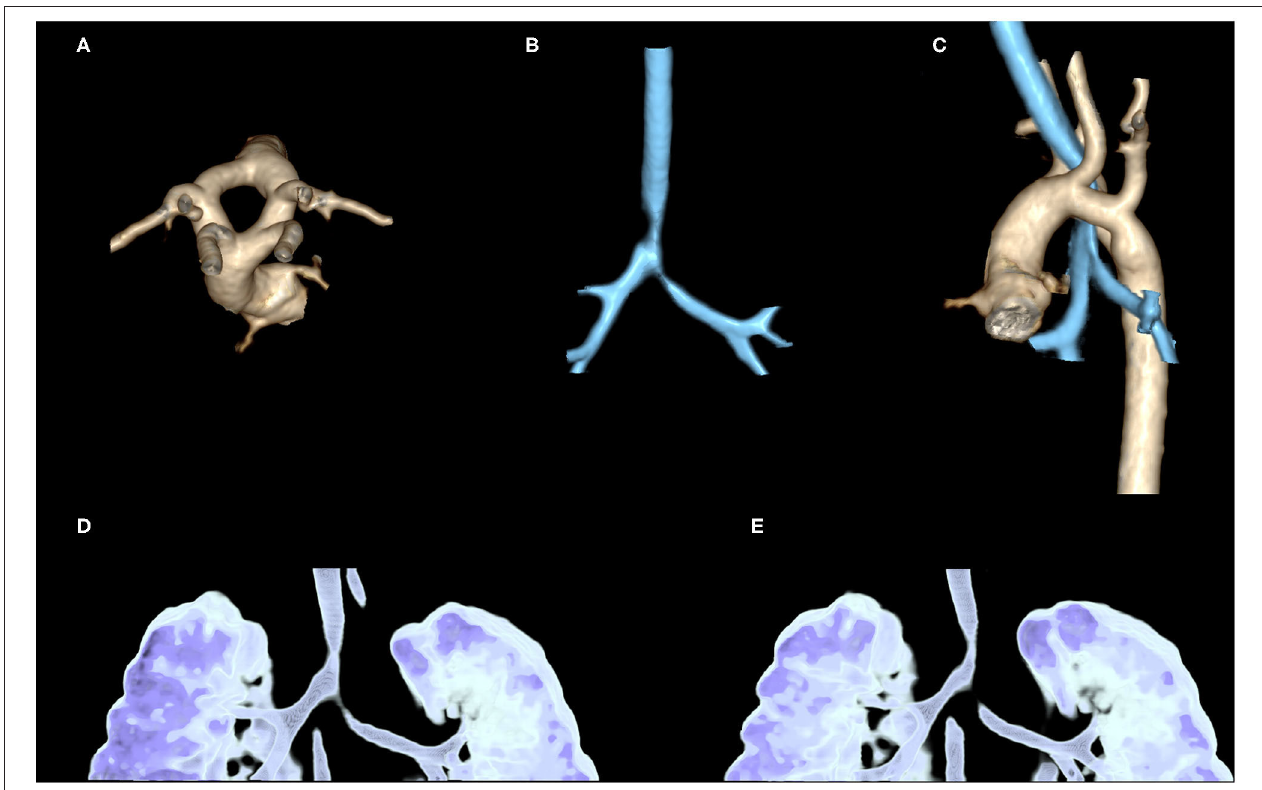
FIGURE 4 | Contrast-enhanced CT in a 2-month-old girl, referred to our hospital after prenatal diagnosis of vascular ring: three-dimensional (3D) volume rendering of thoracic aorta confirms the presence of a double aortic arc with two arches (left and right) equally sized (A) . 3D volume rendering of airways shows stenosis of distal trachea until carina, near the vascular ring (B) . An evaluation of these stenoses compared to thoracic aorta shows that they are, respectively, at the level of the vascular ring and left arterial duct (C) . 3D volume rendering of the dynamic expiratory phase displays associated signs of tracheobronchomalacia of distal trachea and left-sided bronchus with significant variation of caliber between the inspiratory (D) and expiratory phase (E)